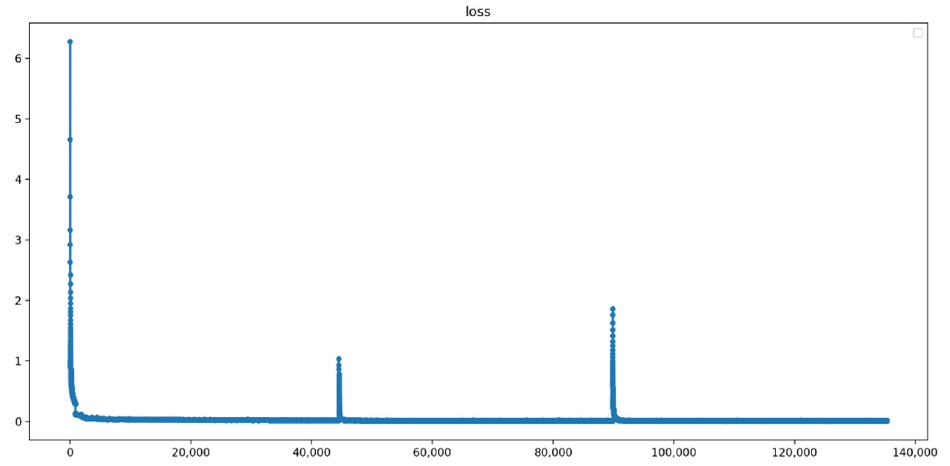
Figure 5. Numerical variation diagram of loss values in the Mask-RCNN training process.